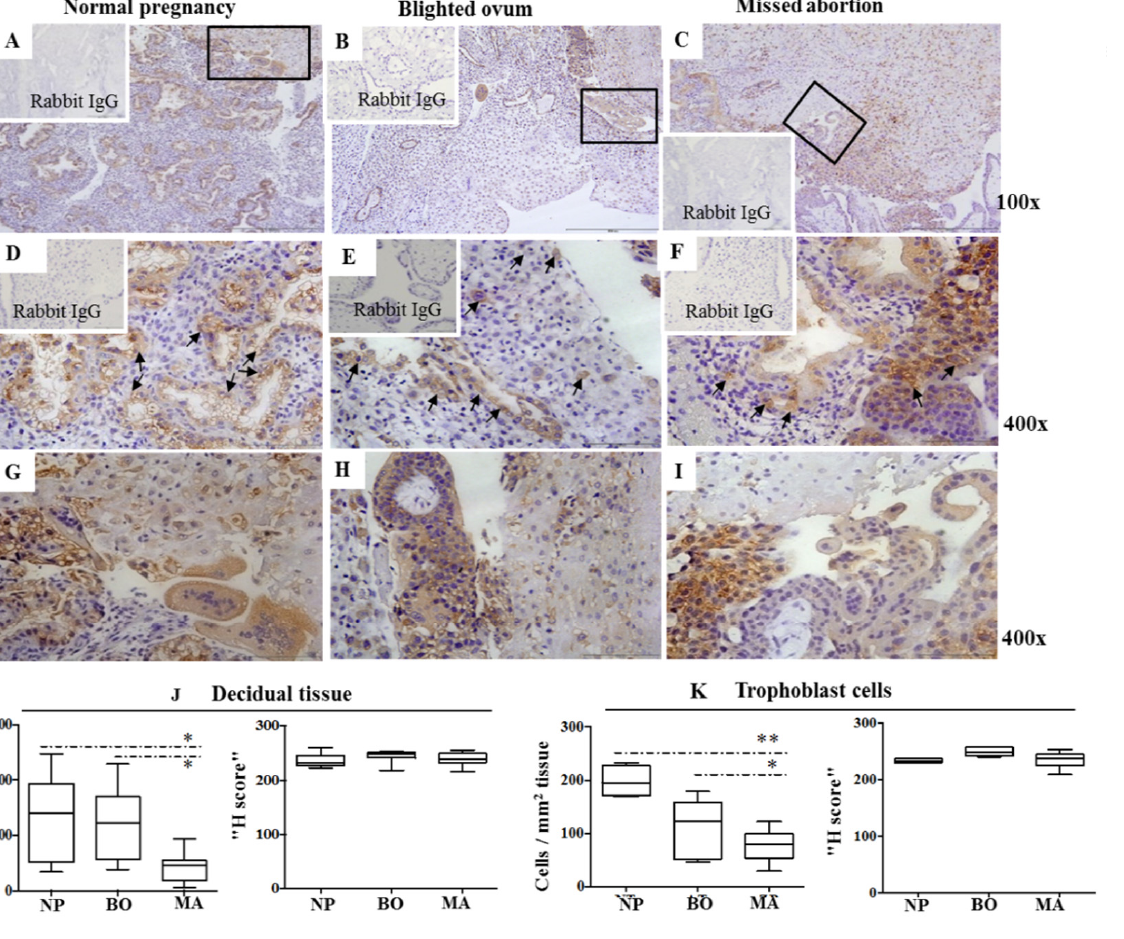
Figure 1. Cytokeratin expression in the decidua of normal pregnancy ( A , D , G ), blighted ovum ( B , E , H ), and missed abortion ( C , F , I ). Immunohistological labeling ( A – F ) using mouse IgG1 anti-Cytokeratin mAbs is visualized in brown color using 3,3-diaminobenzidine. Details from the lined quadrangles (( A – C ), 100 × ) are shown at higher magnification (( D – I ) 400 × ). Black arrows show the sites of trophoblast invasion ( D – F ). Graphs show the number of Cytokeratin-positive cells scattered per mm 2 and the H score for Cytokeratin in the decidual stroma ( J ) and trophoblast cells ( K ) using immunohistology (NP—normal pregnancy; BO—blighted ovum; MA—missed abortion). Ten samples were analyzed per group. Levels of significance: * p = 0.016 and ** p = 0.0078.